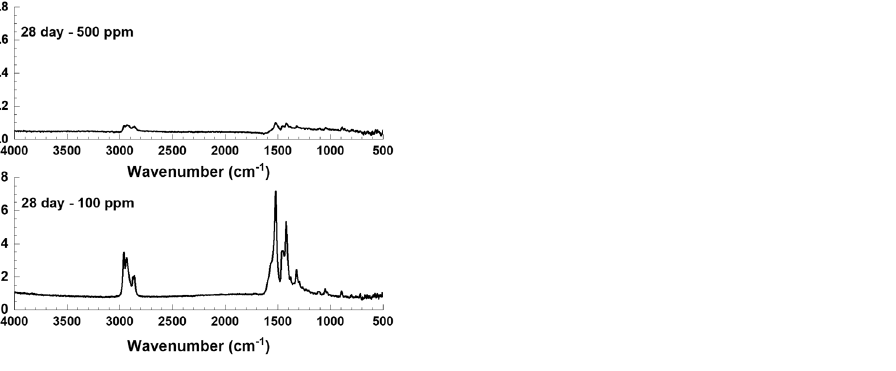
Figure 9. FTIR profiles of the cast iron samples exposed to 100 and 500 ppm chlorides containing engine coolants for 28 days.